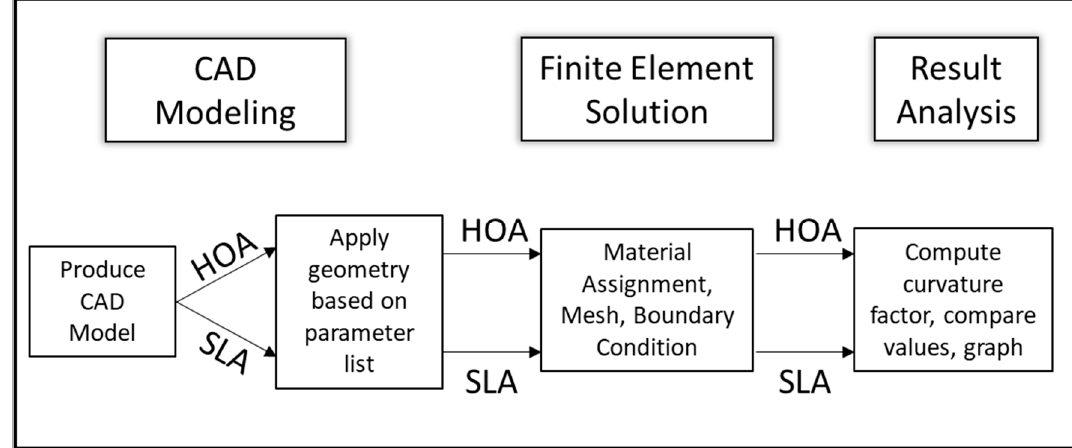
Figure 4. Methodology flow chart.